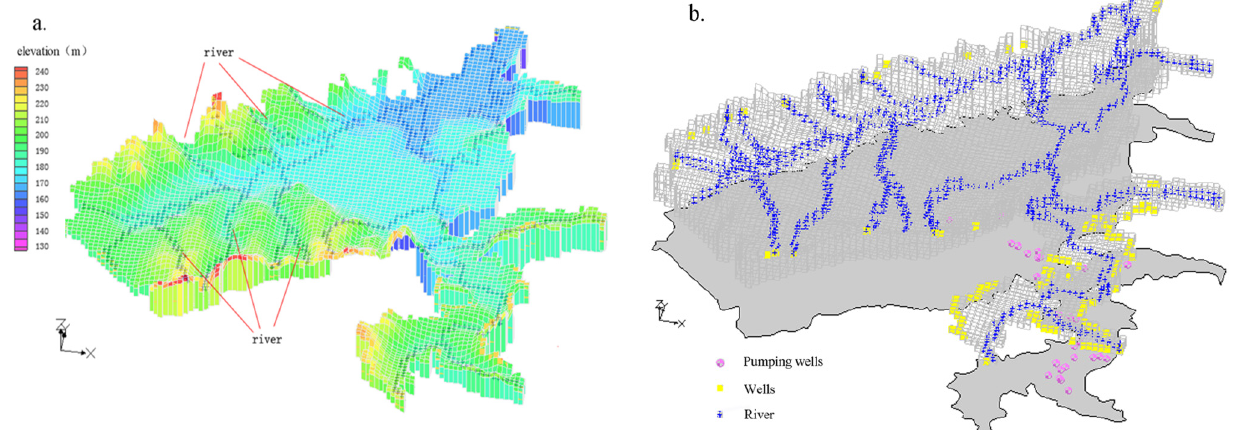
Figure 7. Geometrical model of JUA. ( a ) Geometrical model solid and elevation; ( b )